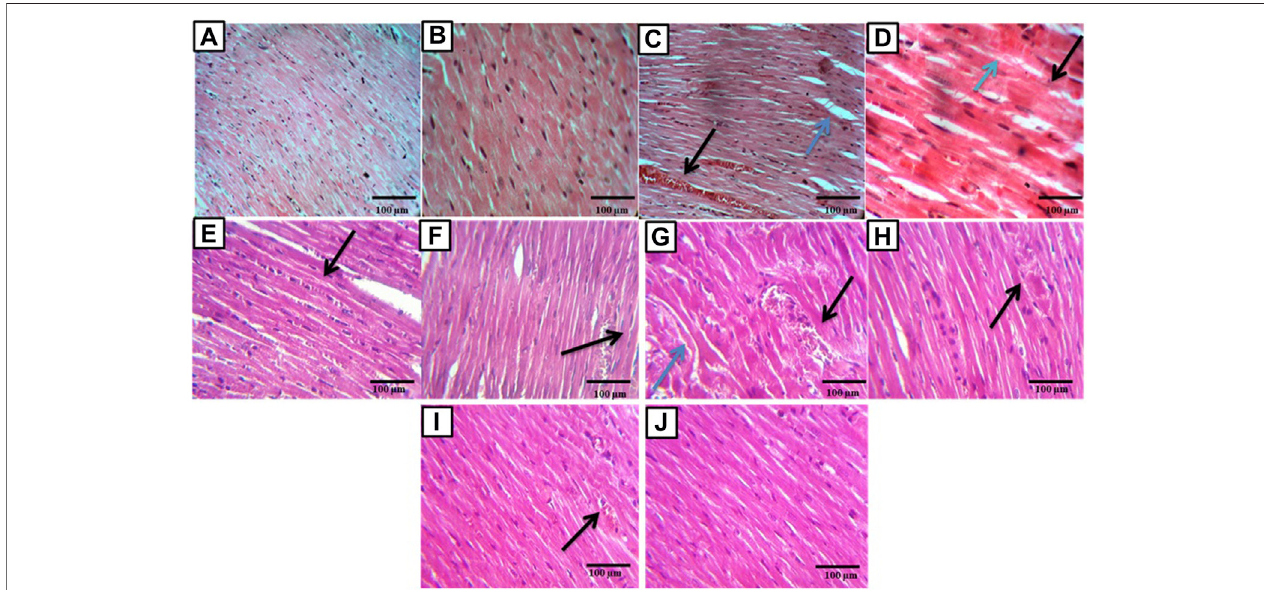
FIGURE 2 | Histopathological examination of cardiac sections: (A,B) sections showed normal rat myocardial tissue, magni fi cation ×40, ×100 respectively. (C) Section of the DOX affected myocardial tissue showed congested and dilated blood vessel (black arrow) with edema (blue arrow) (×40). (D) Section ofthe DOX affected myocardial tissue showed fragmented muscle fi bers (black arrow), decreased number of nuclei, and extravasation of R.B.C.s (blue arrow) (×100). (E,F) Sections of the DOX+FebuoxatatgroupshowedimprovedDOX-inducedmyocardialdamagewithpreservednucleiandnomuscle fi bersfragmentationbutcongestedanddilated bloodvesselsarestillpresent(arrow)(×40),nomuscles fi bersfragmentationbutodemaandextravasationofR.B.C.sarestillpresent(blackarrow)(×100). (G,H) Sections of the DOX + P.Ginseng group showed improved DOX-induced myocardial damage apart from odema and vaculations (blue arrows) (×40) and showed area of coagulative necrosis, vascular congestion and chronic in fl ammation cell (black arrow) (×100). (I,J) sections of the DOX + combination group showed nearly normal- looking cardiac muscle tissue (×40) apart from a congested blood vessel (black arrow) (×100).